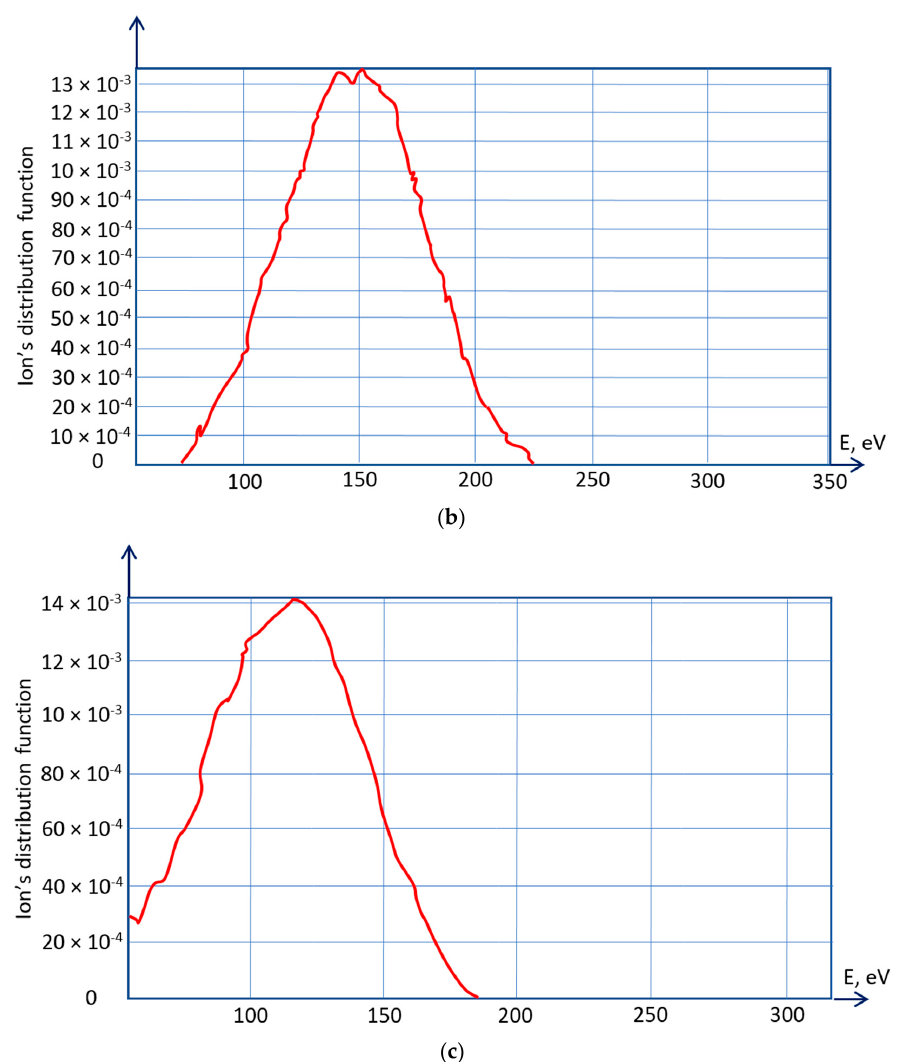
Figure 6. Distribution curves of argon ions depending on the energy of the low-voltage ion source. At discharge voltage of: ( a ) − 250 V, ( b ) − 230 V, ( c ) − 200 V.